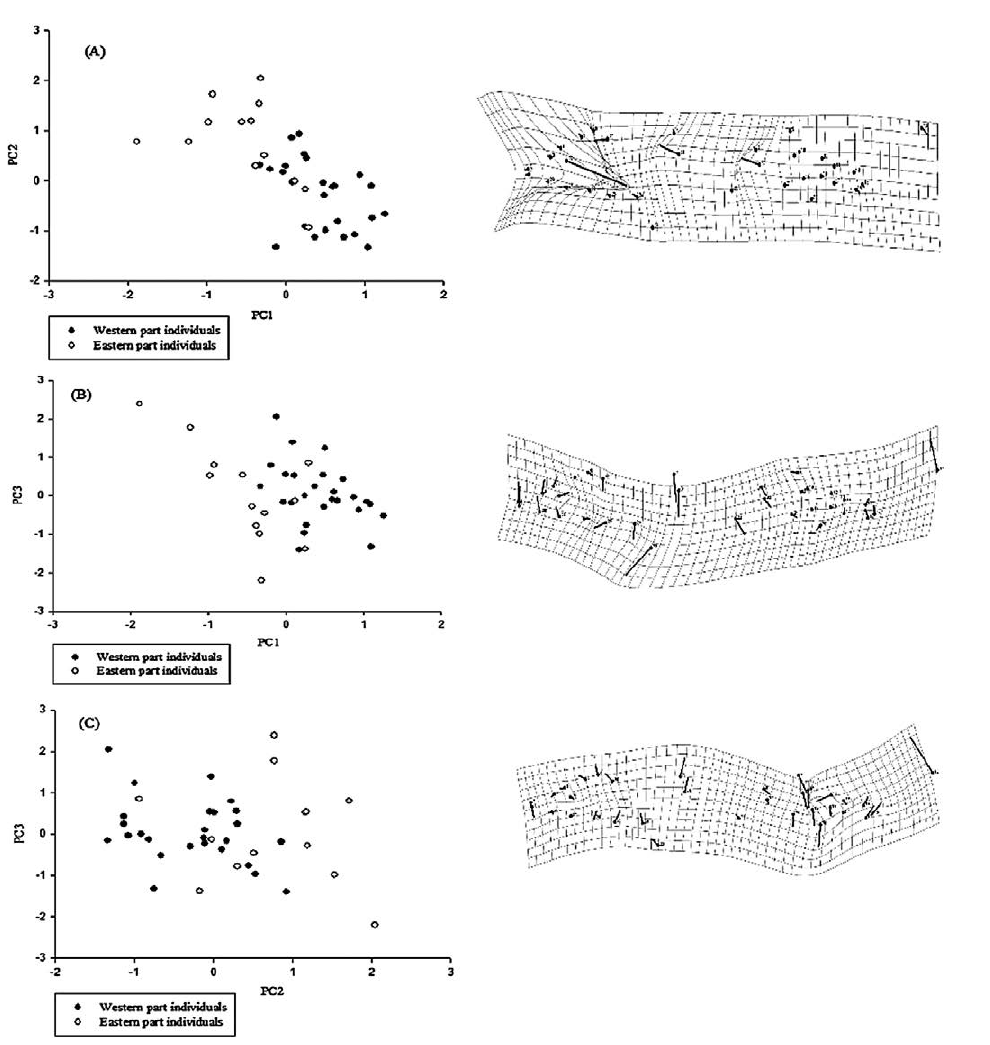
Fig. 3. – Landmark-based method scores from principal component analysis of juvenile Persian sturgeon for body shape in two regions. The scatter plot shows individual fish scores for PC1 vs. PC2 (A), PC1 vs. PC3 (B) and PC2 vs. PC3 (C), which together explain the total variance of 75.79%. Deformation grids (splines) are reported on the right side of each scatter plot. The splines represent fish shape variability along each relative PC